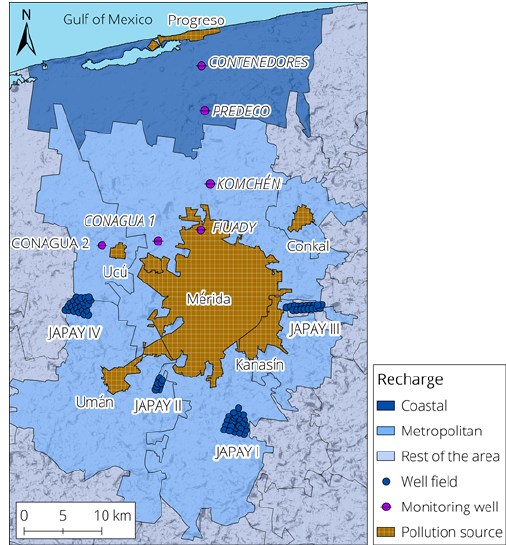
Figure 7. Conceptual model of the